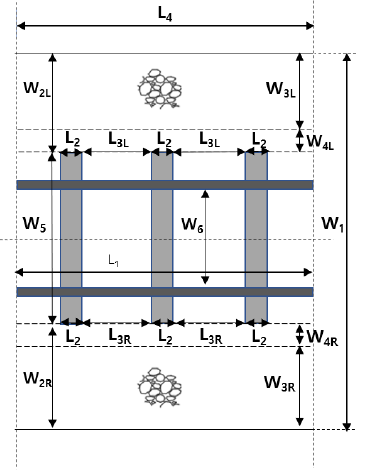
Figure 5. Illustration of representative parameters of the ballasted track (top